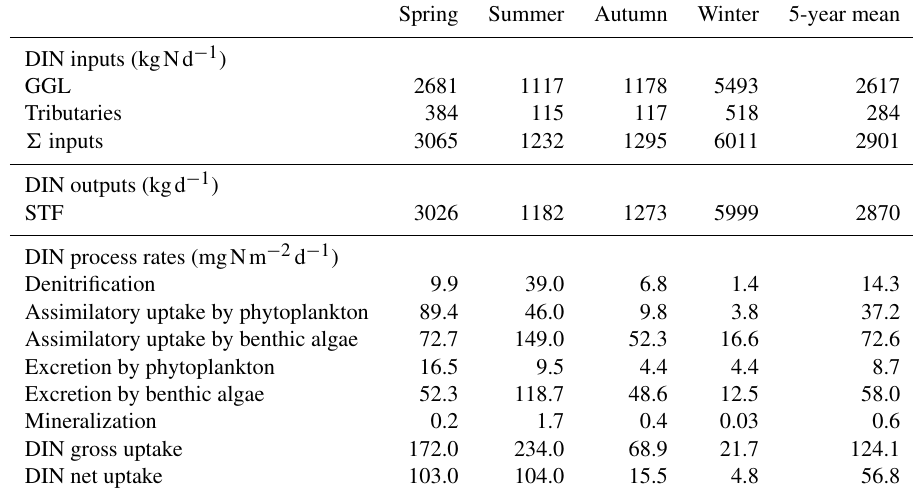
Figure 3. (a) Comparison of the daily GPP calculated by WASP (simulated GPP) and by the single-station method (measured GPP). (b) The two components of simulated GPP, i.e. GPP by phytoplankton (GPP p ) and by benthic algae (GPP b ) are shown. Table 4. Seasonal DIN budget including inputs, outputs, and process rates in the Lower Bode (average results from 2014 to 2018). Spring Summer Autumn Winter 5-year